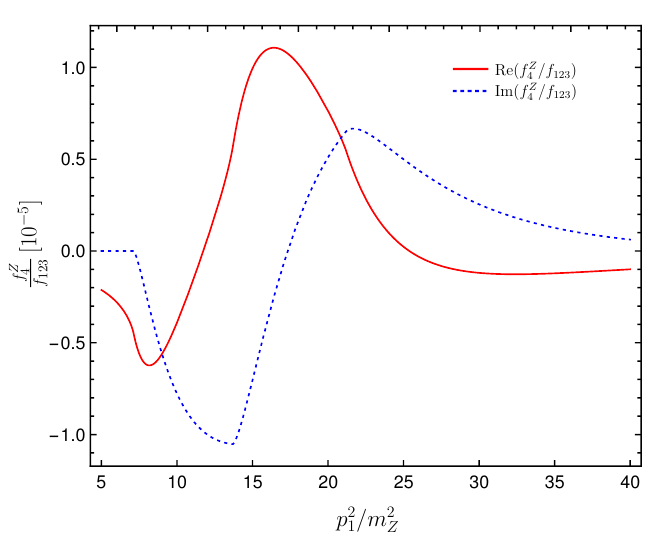
Figure 4. The CP-violating f Z 162 : 9 GeV and m h normalized to m 2